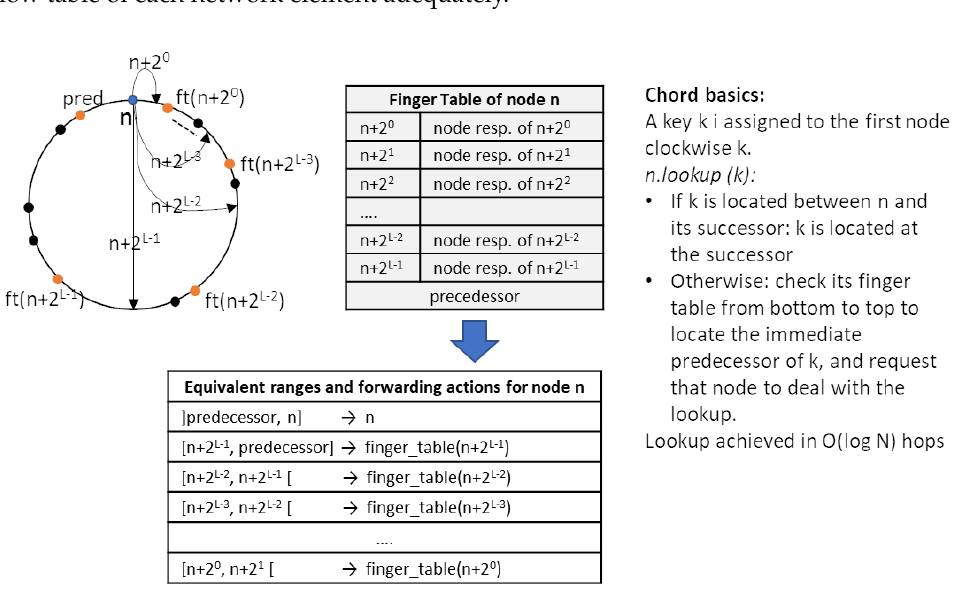
Figure 2. The upper part of the figure depicts the Chord basics: the definition of the finger table and the lookup mechanism. At the bottom of the figure, the set of value ranges and associated actions after transforming the lookup mechanism into a network level solution is